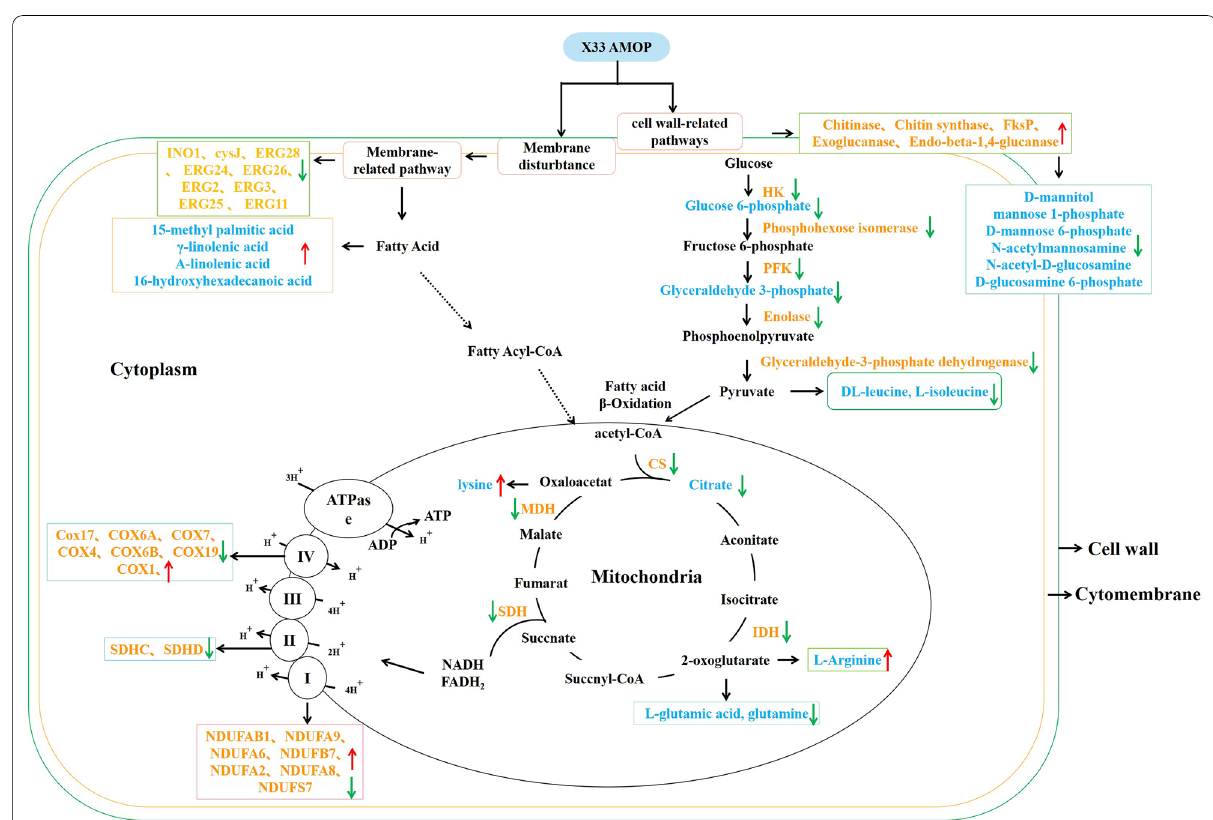
Fig. 3 Accumulation of DEGs and differentially regulated metabolites in P. digitatum cells under 1.2 g/L X33 AMOP treatment. Metabolites marked with blue font indicate regulated in P. digitatum cells. Genes marked with yellow font indicate regulated in P. digitatum cells. Red arrows represent DEGs or metabolites were upregulated. Green arrows represent DEGs or metabolites were